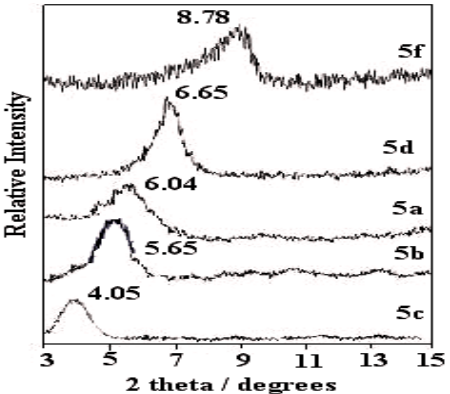
Figure 4. X-ray diffraction patterns of Na-MMT (5f), Organoclay (5d) and PA-nanocomposite films 5a–5c.